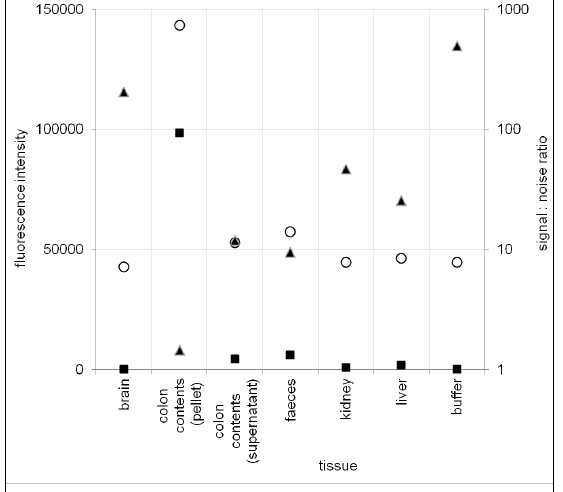
Figure 5. Fluorescent Signal : Noise ratio of FP assay at 1:100 dilution of sample. Fluorescence Intensity reading prior addition of alexa-660 folate ligand ( ¤ ); Fluorescence Intensity reading after addition of alexa- o 660 folate ligand ( ); Signal: Noise ratio (alexa 660 folate fluorescence/ sample fluorescence) ( p ) [right hand axis]